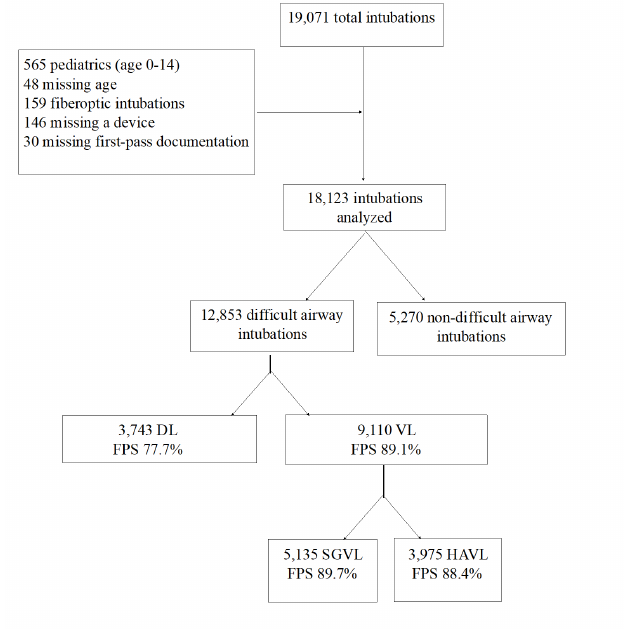
Figure 1. Flowsheet of intubations included and analyzed during the study period. Note that 948 intubations were excluded; neither were 5,270 intubations included in the final analysis as they did not meet criteria for a difficult airway. DL, direct laryngoscopy; VL, video laryngoscopy; FPS, first-pass success; HAVL, hyperangulated video laryngoscopy; SGVL, stan- dard geometry video